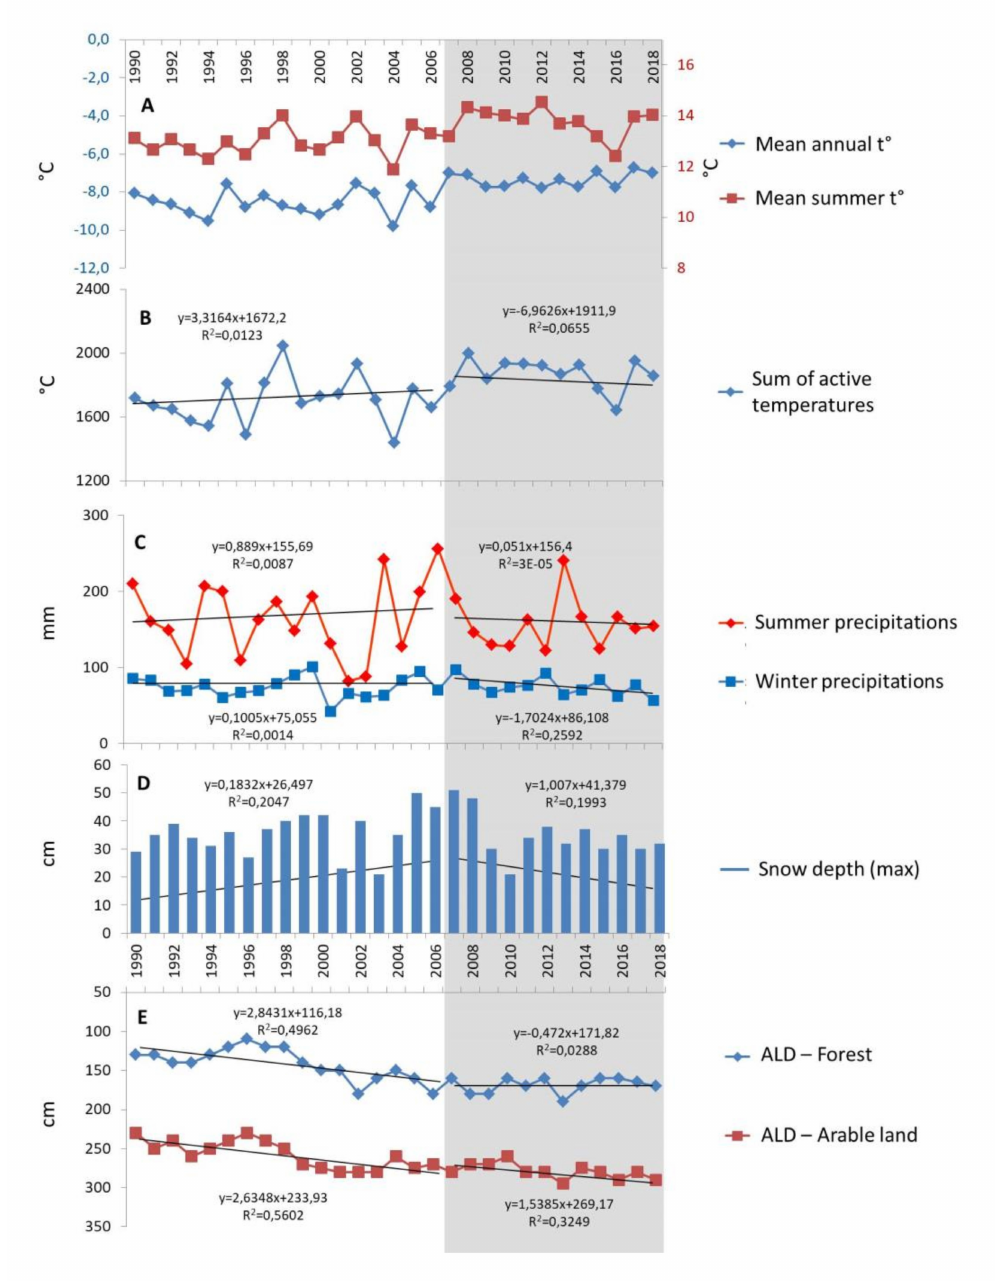
Figure 3. ( A ) The mean annual temperature***, ( B ) the sum of active temperatures higher than 10 ◦ C***, ( C ) winter–summer precipitation*, ( D ) the maximum snow depth*, ( E ) the active layer depth (ALD) and their trends during the MAAT periods B and C***. White background: the second MAAT period B (1990–2006). The grey background is the Table 2007. Significance of difference between B and C period of MAAT; *-at p < 0.05, **-at p < 0.01, ***-at p <